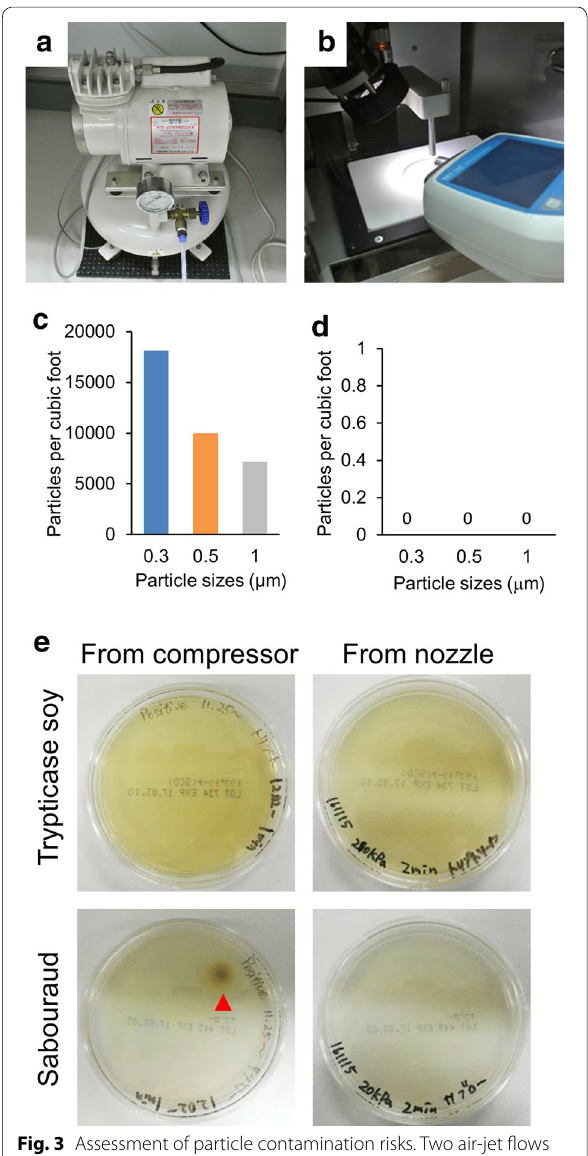
Fig. 3 Assessment of particle contamination risks. Two air-jet flows were investigated from: a an oil-free air compressor and b the air nozzle of the non-contact wettability assessment system. Graphs c , d show the numbers of particles with the diameters of 0.3, 0.5, and 1 μm in the two types of air-jet flows (N 1). Photographs e show = the results of micro-organism tests. The red arrow head indicates the colony of